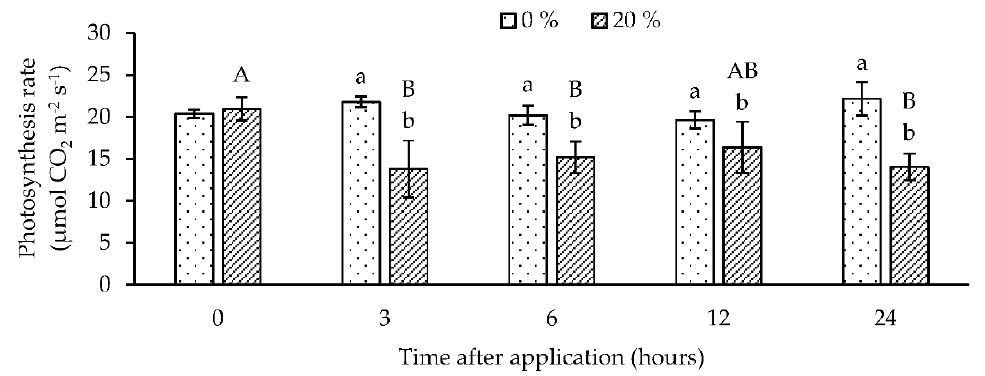
Figure 9. Photosynthesis rate of the youngest and second youngest fully expanded leaves of spring wheat (cv. Amaretto) after foliar fertilization with UAN solution (0% or 20% of N in solution) at 0, 3, 6, 12, and 24 HAFNf. Data are the means of three independent biological replicates ± standard error; small letters indicate difference between N treatments at each evaluation time, and capital letters indicate difference between the evaluation times in each N treatment according to Tukey’s post hoc test ( p <